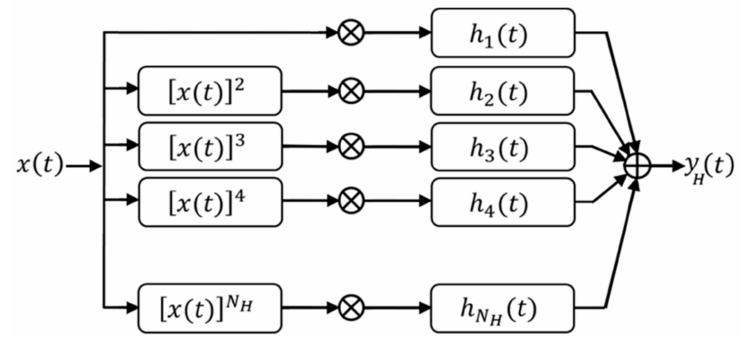
Figure 1. The Hammerstein